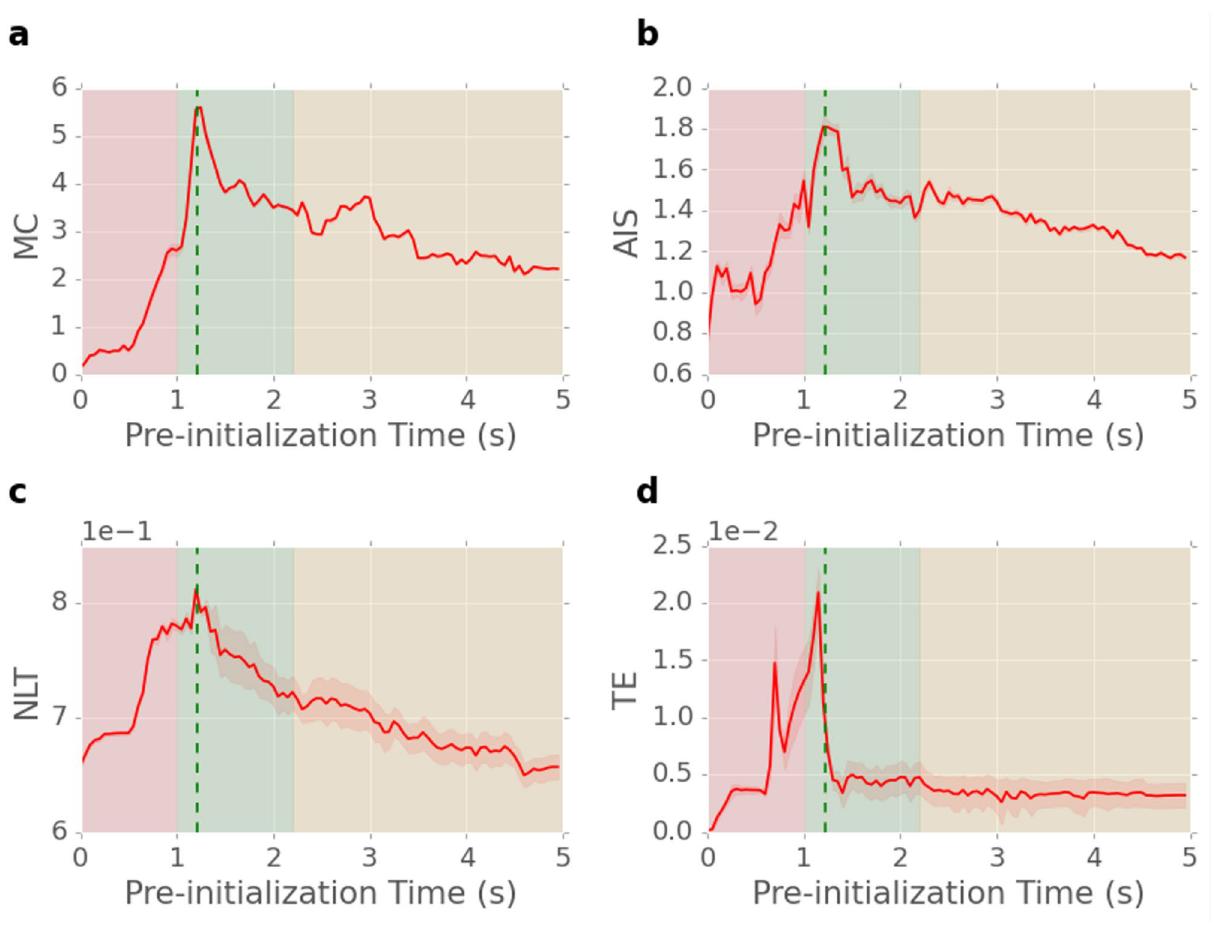
Figure 5. Information processing tasks and corresponding information dynamics measures for networks pre-initialised with different initial states (shaded regions represent standard error): ( a ) memory capacity (MC) task performance; ( b ) average active information storage (AIS) for MC; ( c ) non-linear transformation (NLT) accuracy; ( d ) average transfer entropy (TE) of NLT. Plots in ( a ) and ( b ) are averaged over multiple iterations of MC due to the inherent randomness of the task. Standard error is too small to be noticed. Plots in ( c ) and ( d ) are averaged over different amplitudes of the NLT task ranging between 0.6–1 V.